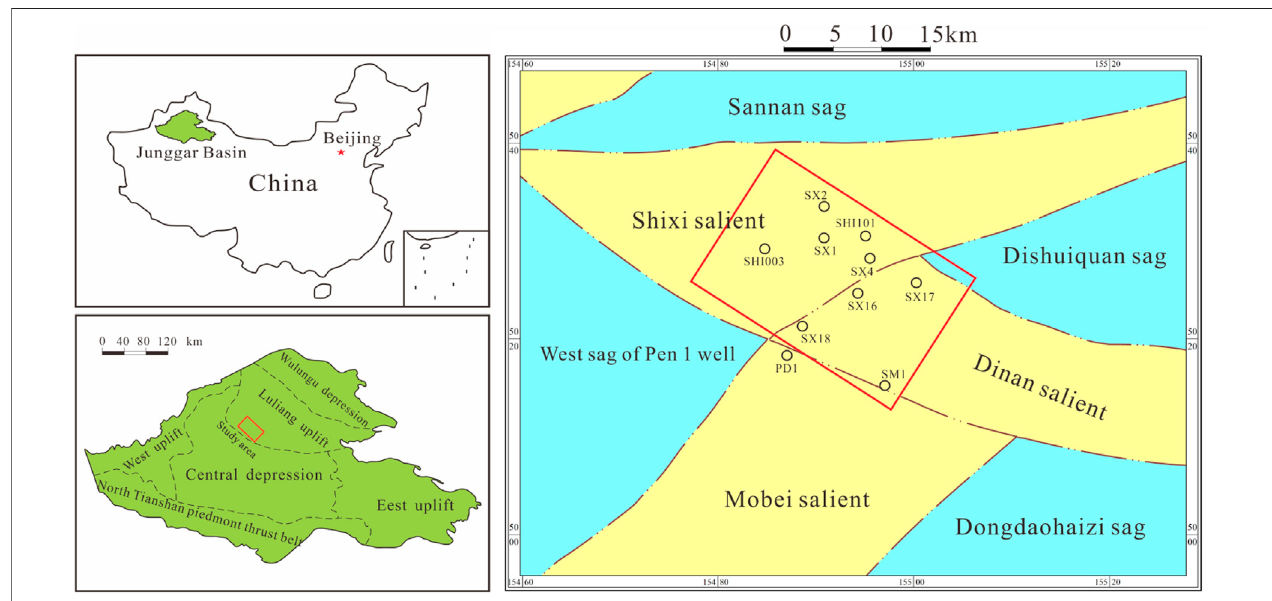
FIGURE 1 | Tectonic unit of the Junggar Basin and studying area.